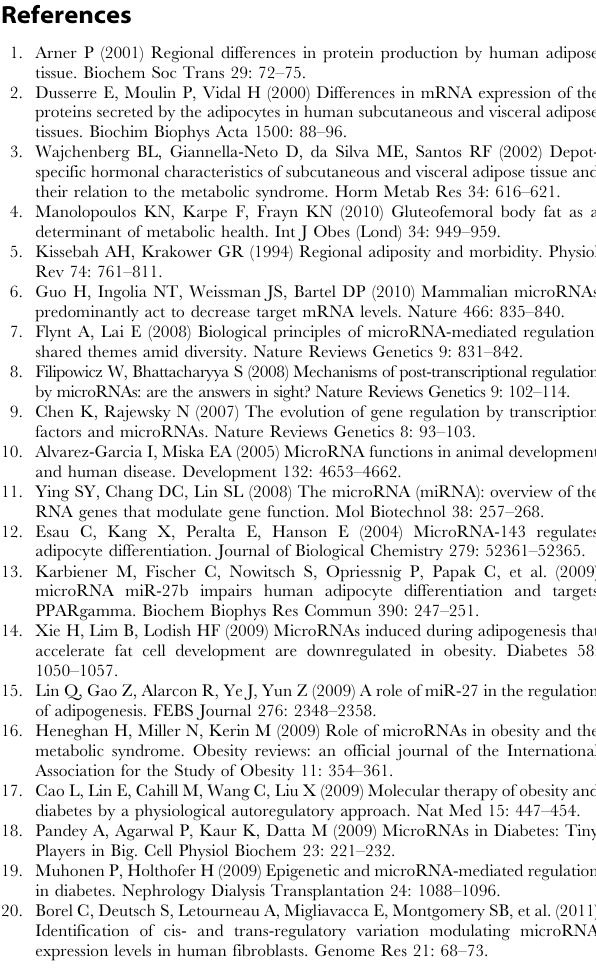
Table S8 miRNAs significantly associated with their mRNA targets in gluteal adipose tissue. Table S9 Significant KEGG terms from miRNA-mRNA association analysis in abdominal adipose tissue. Table S10 Significant KEGG terms from miRNA-mRNA association analysis in gluteal adipose